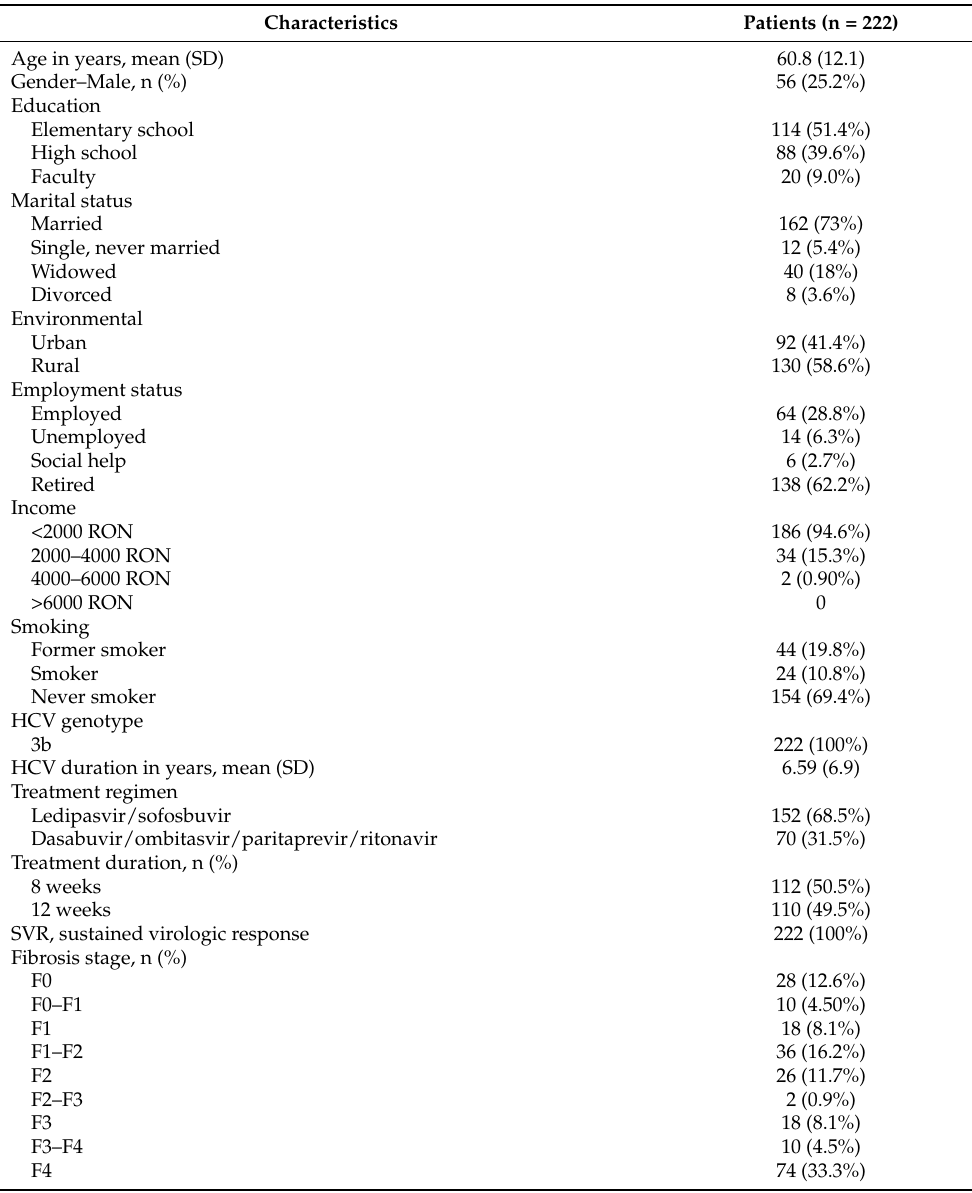
Table 1. Baseline characteristics of